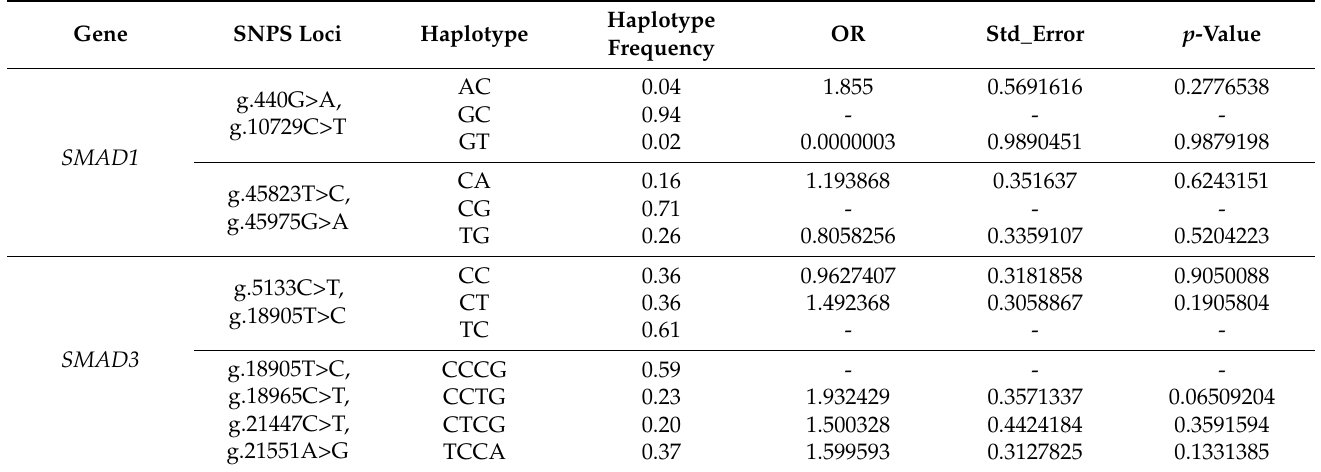
Figure 6. Linkage disequilibrium analysis of single nucleotide polymorphisms (SNPs) in SMAD1 ( A ) and SMAD3 ( B ) genes. The number in the blank indicates the D ′ value (%). Table 6. Haplotypes of SMAD1 and SMAD3 genes SNPs loci.